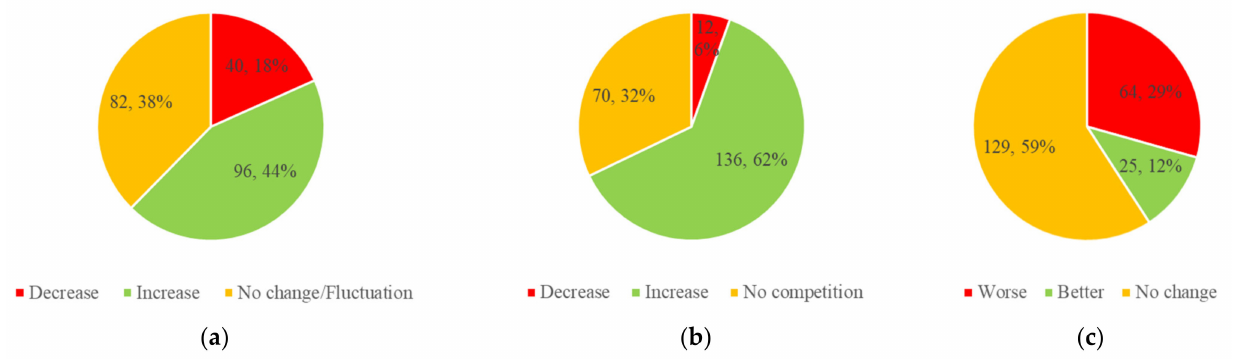
Figure 2. Tea farmers’ perception of income ( a ), market competition ( b ), and environmental condi- tions ( c ) concerning tea cultivation and production. Illustrated by the number of respondents and the